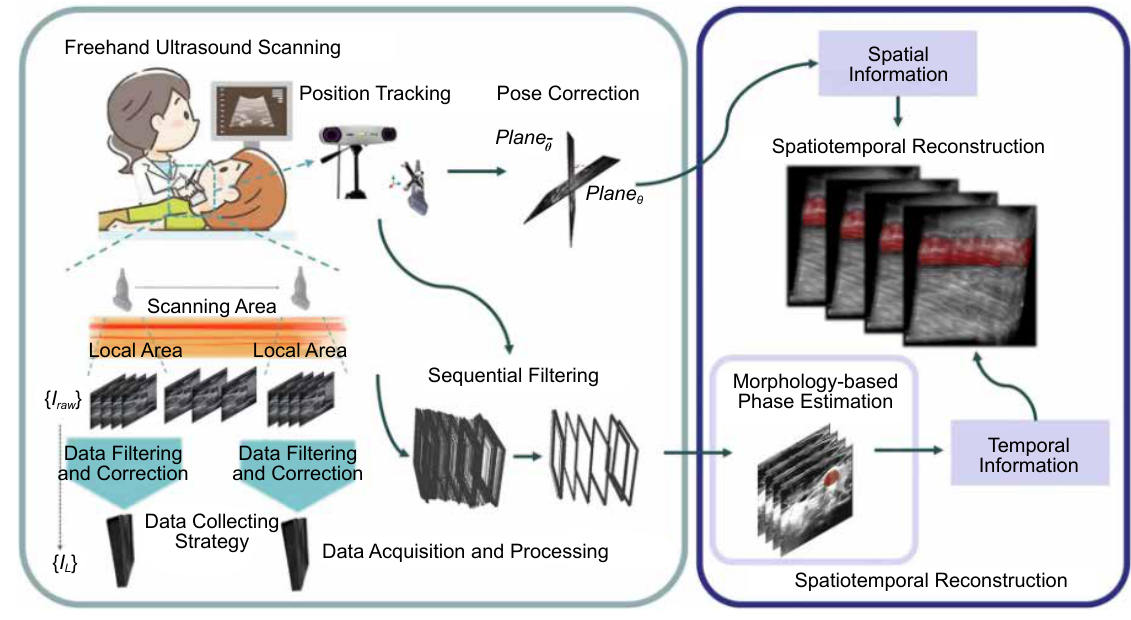
Figure 7 Spatio-temporal reconstruction framework